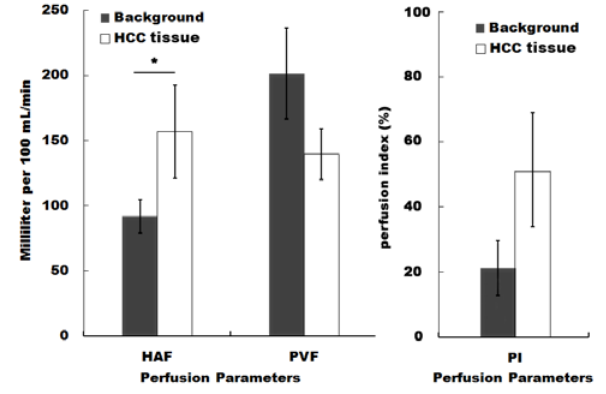
Figure 1 : Hepatocellular carcinoma (HCC) patients exhibited higher intrahepatic blood flow and perfusion index. Parameters including hepatic artery flow (HAF), portal vein flow (PVF), and perfusion index (PI) are presented as mean±SE. * p<0.05 HCC vs control.